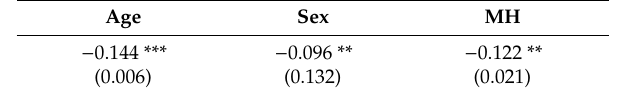
Table 4. Model 2. Dependent variable (achievement dimension of an entrepreneurial attitude). Independent variables: age, sex, level of studies, professional activity, and